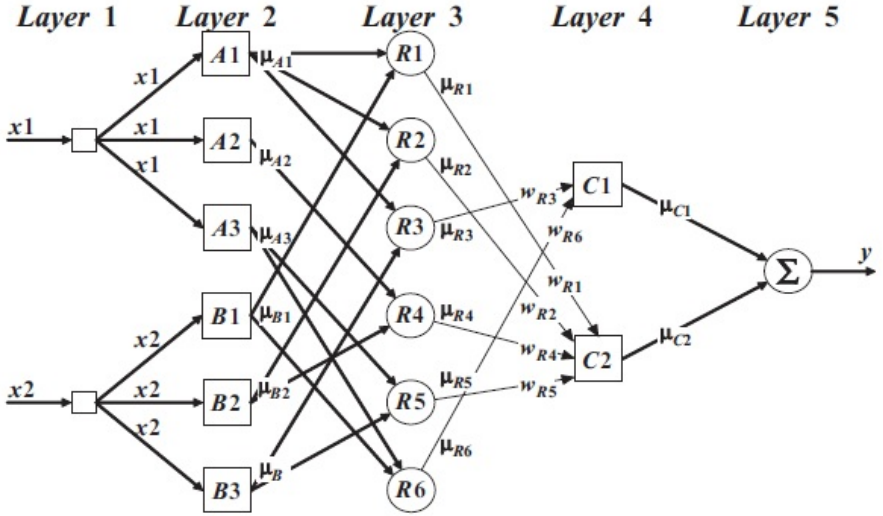
Figure 3. Five layers of fuzzy neural network-based expert inference system.